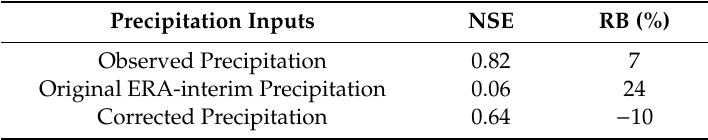
Table 4. Performance of simulations with di ff erent precipitation